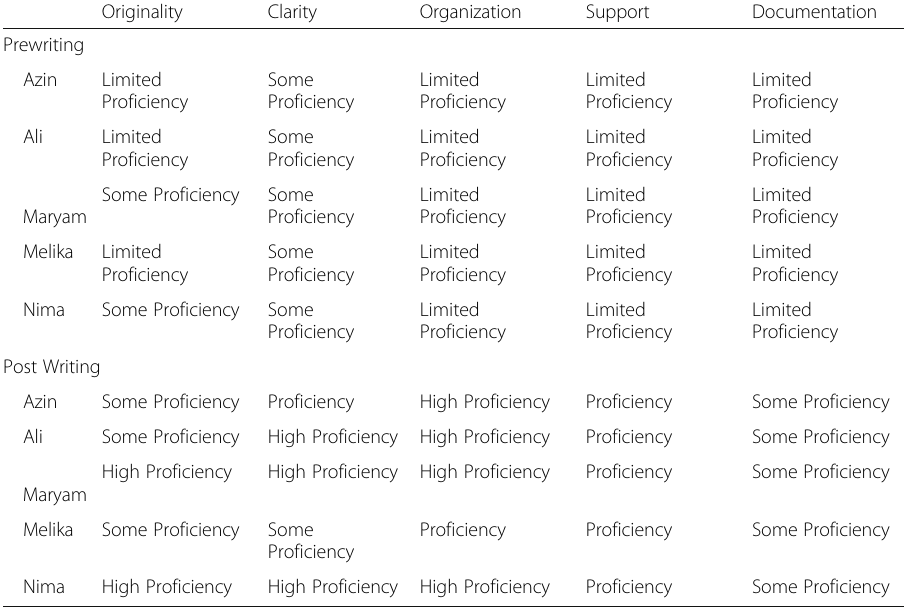
Table 4 The evaluation of the participants ’ writings Originality Clarity Organization